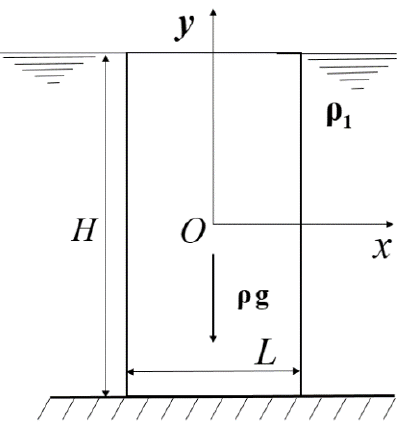
Figure 7. Problem of the partition wall.